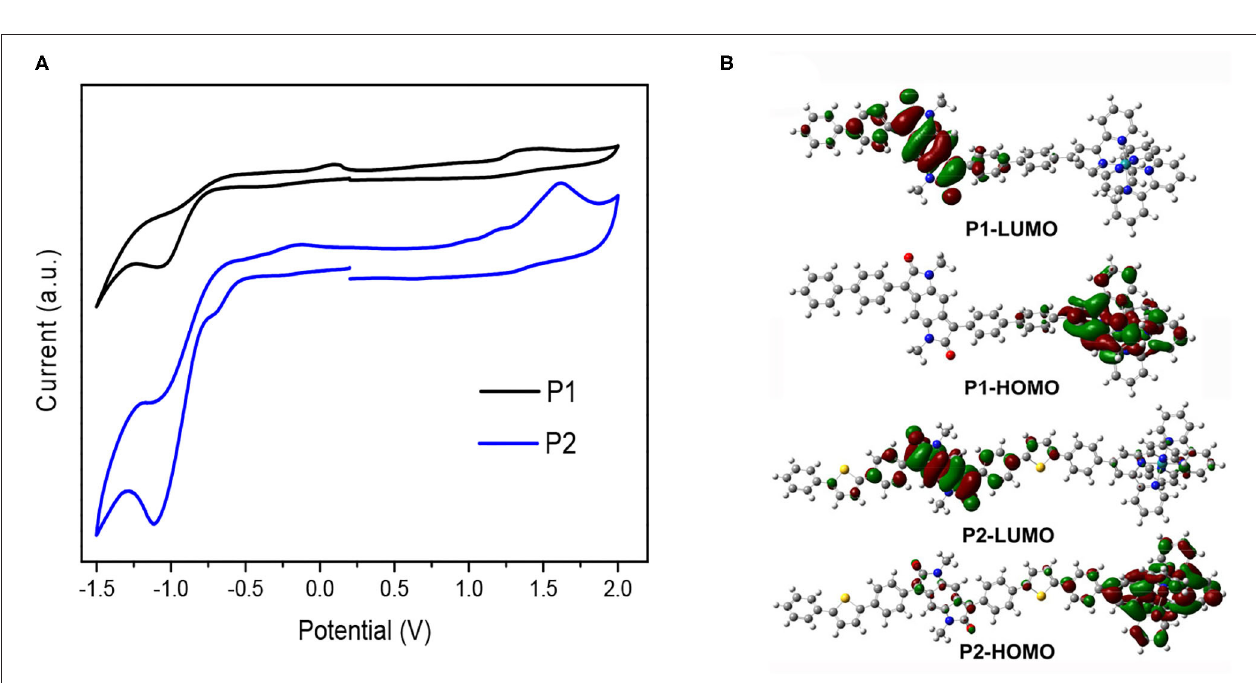
FIGURE 2 | Cyclic voltammograms (CV) curves of the metallo-supramolecular polymers (A) and simulated HOMO and LUMO orbitals for the polymers P1 and P2 calculated at the B3LYP/6-31(d,p) level (B) .